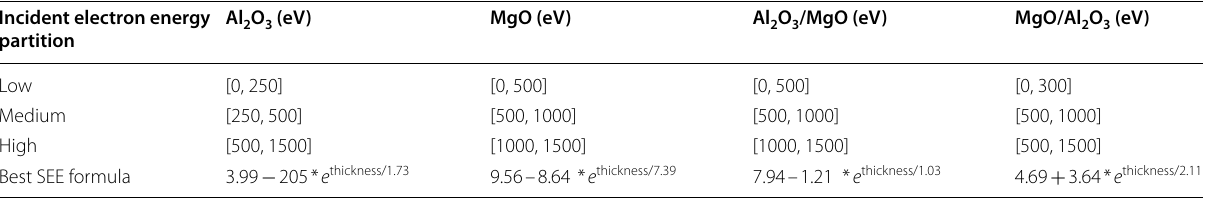
Because the SEE of Al 2 O 3 / MgO is stable in the medium energy region, the incident electron energy can be excluded as a variable factor. We choose the medium incident electron energy 700 eV as the standard to meas- ure the SEE level of Al 2 O 3 /MgO, the empirical formula for the thickness of alumina material and the best SEE is obtained by fitting as shown in Fig. 11c.